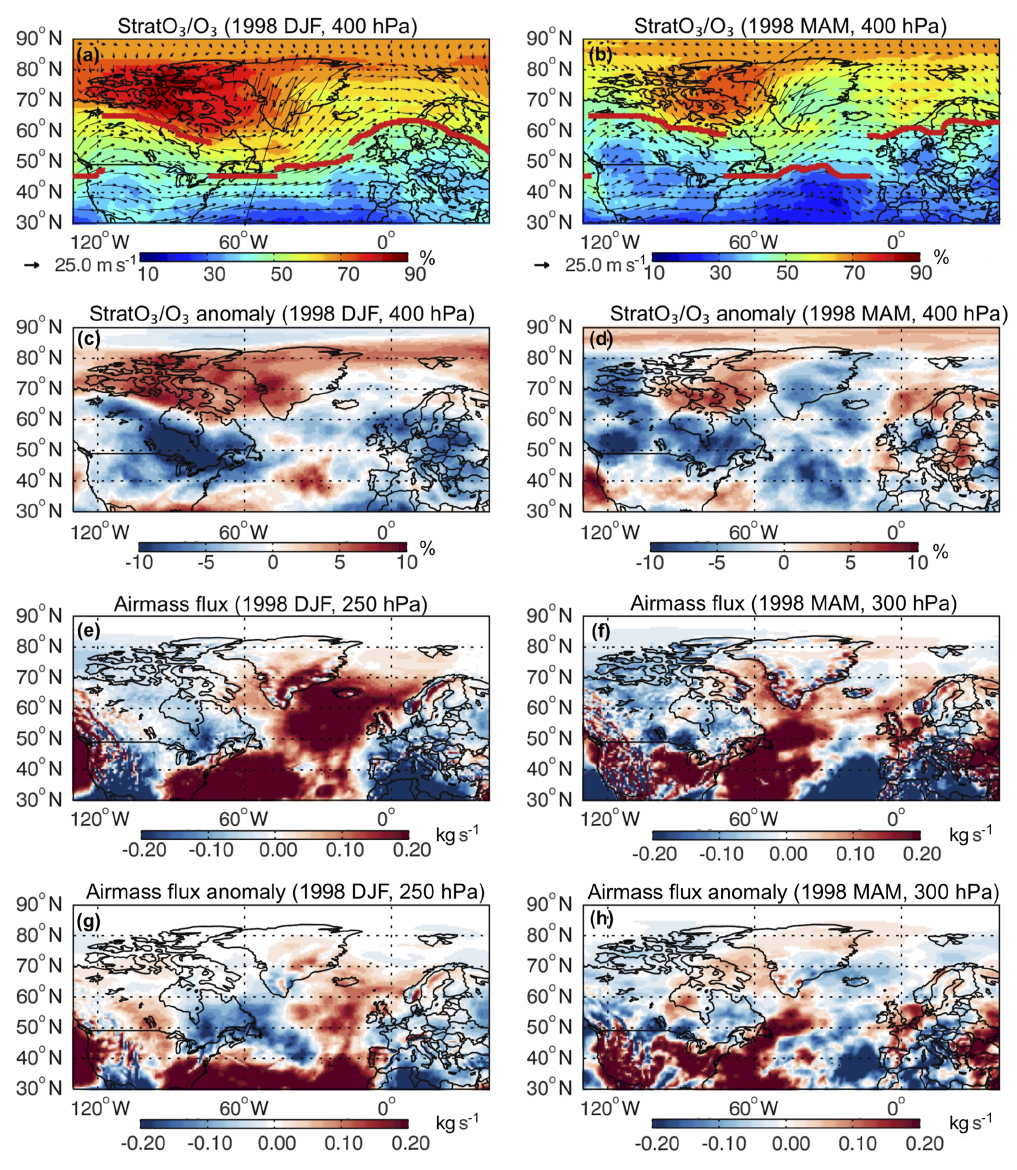
Figure 6. Similar to Fig. 5 but for the year